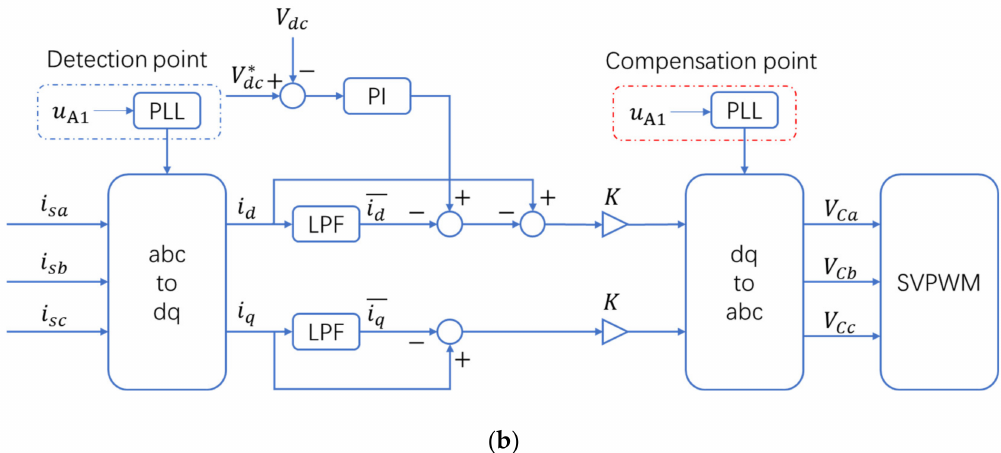
Figure 6. Inductive active filter harmonic damping control system block diagram. ( a ) VSI harmonic damping control block diagram of a classic HIAF system. ( b ) VSI harmonic damping control block diagram of the proposed HIAF system. Star* means reference value.